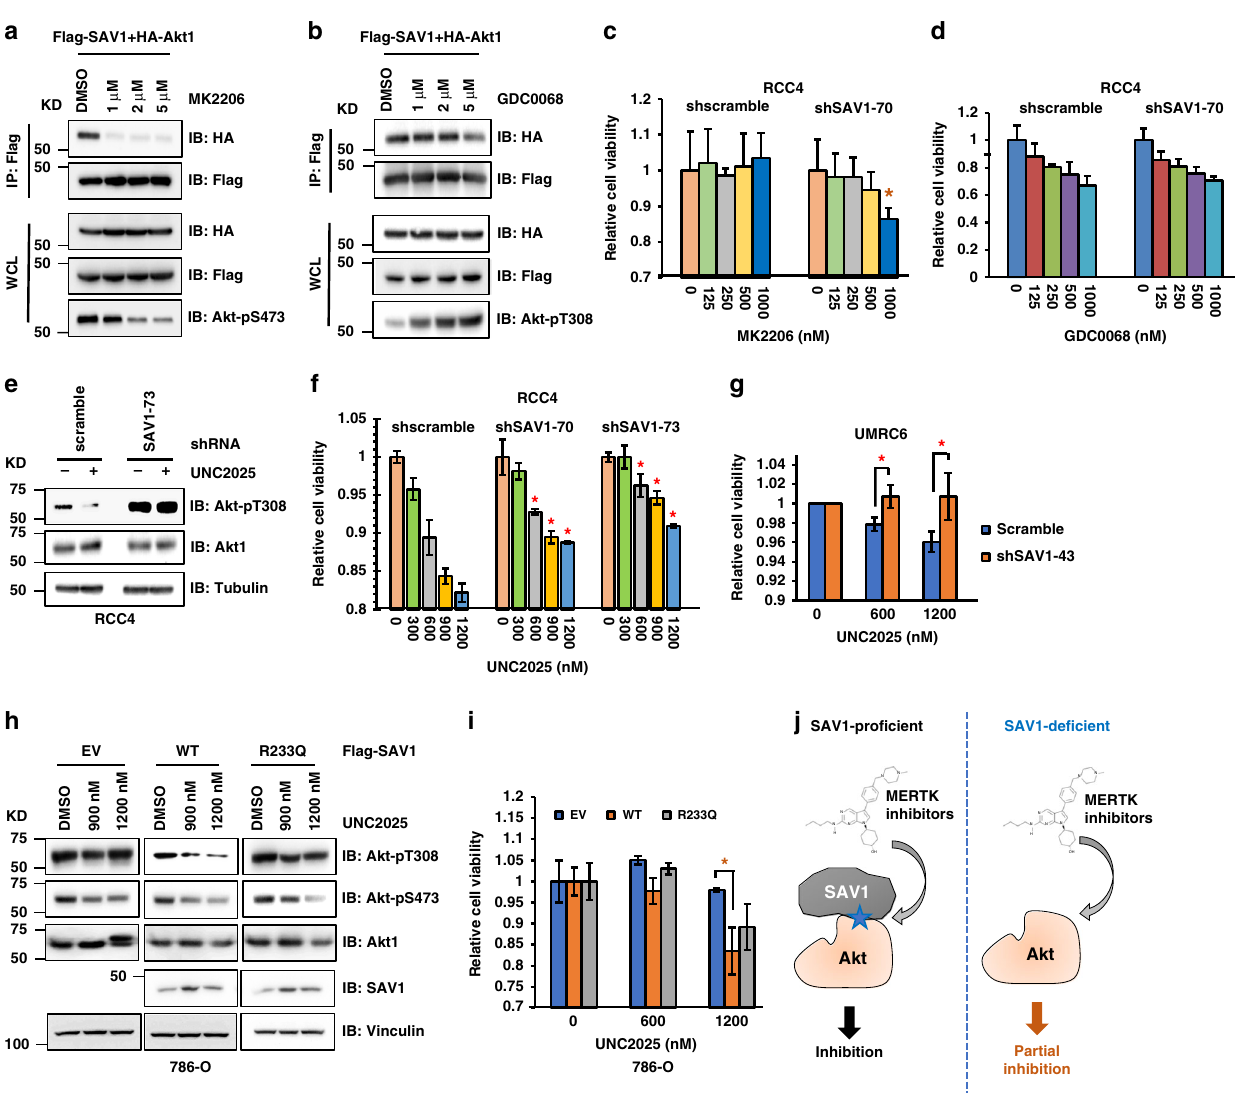
Fig. 4 SAV1 is necessary for MERTK inhibition-mediated suppression of Akt activation in RCC cells. a , b IB analysis of WCL derived from HEK293 cells transfected with Flag-SAV1 and HA-Akt1. Where indicated, cells were treated with indicated doses of MK2206 ( a ) or GDC0068 ( b ) for 10 h before cell collection. c , d Cell viability assays were performed with WT- and SAV1-depleted RCC4 cells treated with either indicated doses of MK2206 ( c ) or GDC0068 ( d ) for 3 days (mean± SD, n = 3). 1000 cells were plated in each well on 96-well plates. * P < 0.05 (Student ’ s t test). e IB analysis of WCL derived from indicated RCC4 cells treated with MERTK inhibitor UNC2025 (400 nM) for 2 h before cell collection. f , g Cell viability assays were performed with WT- and SAV1-depleted RCC4 ( f ) or UMRC6 ( g ) cells treated with indicated doses of MERTK inhibitor UNC2025 for 3 days (mean ± SD, n = 3). * P < 0.05 (Student ’ s t test). h IB analysis of WCL derived from 786-O cells transfected with indicated SAV1 constructs and treated with indicated doses